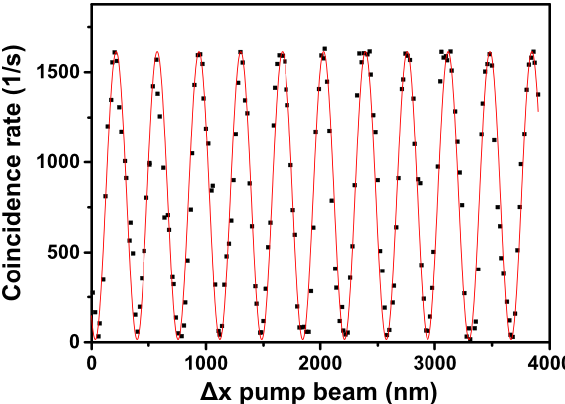
Figure 4. Second-order interference of the single signal photons from crystals BBO1 or BBO2 at Detector A in coincidence with the single idler photons from crystals BBO1 or BBO2 at Detector B, as a function of Pump 1 path delay for BBO1 (see Figure